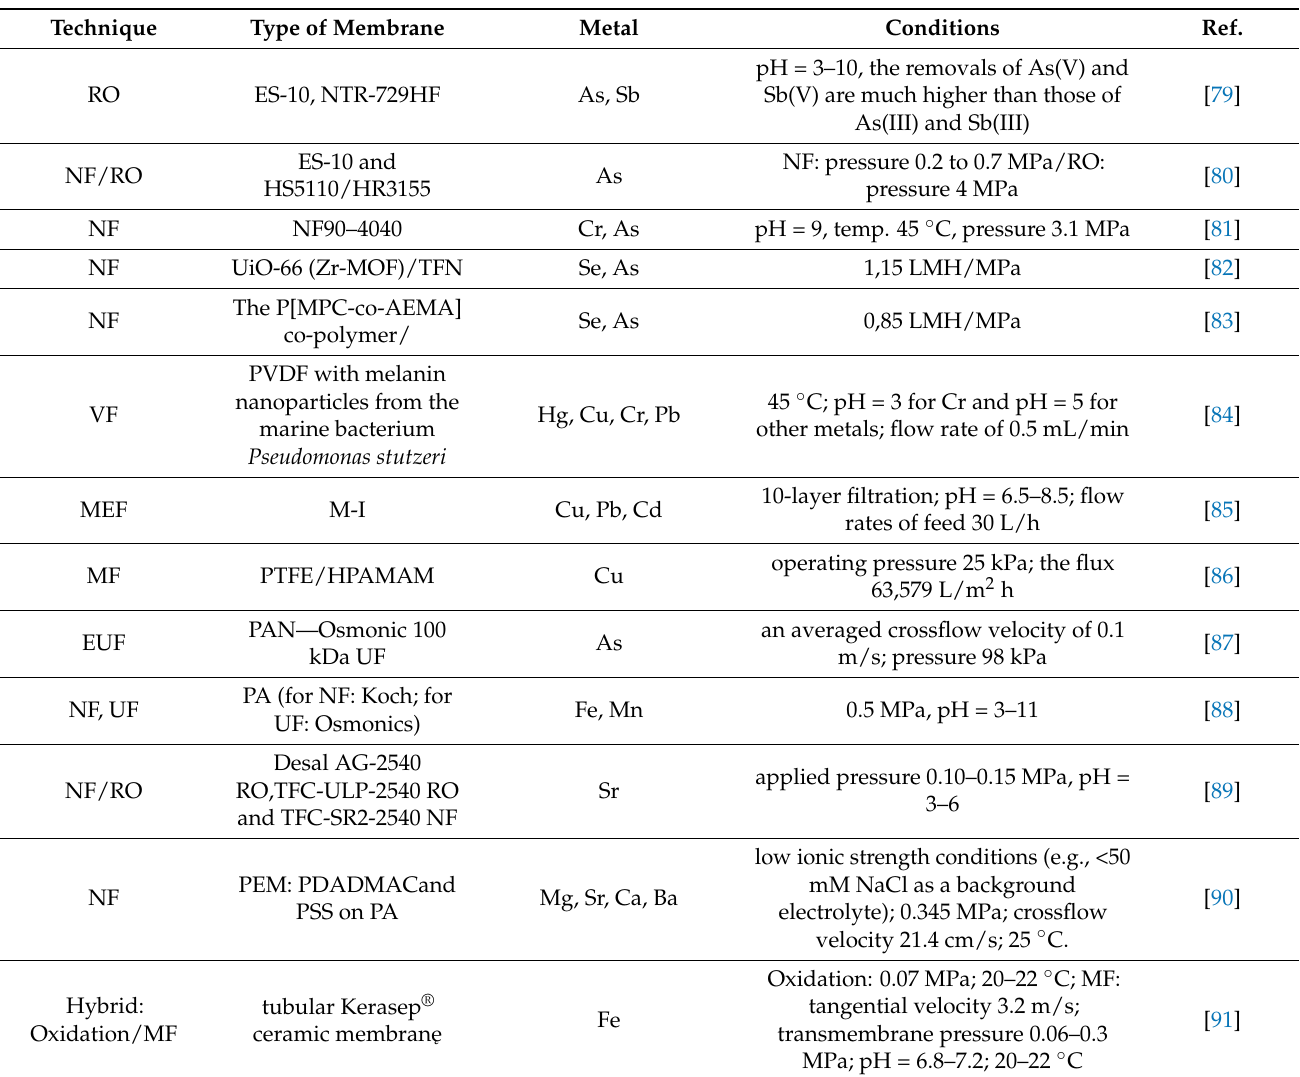
Table 3. Examples of the use of membrane techniques to remove metals from groundwater. Technique Type of Membrane Metal Conditions